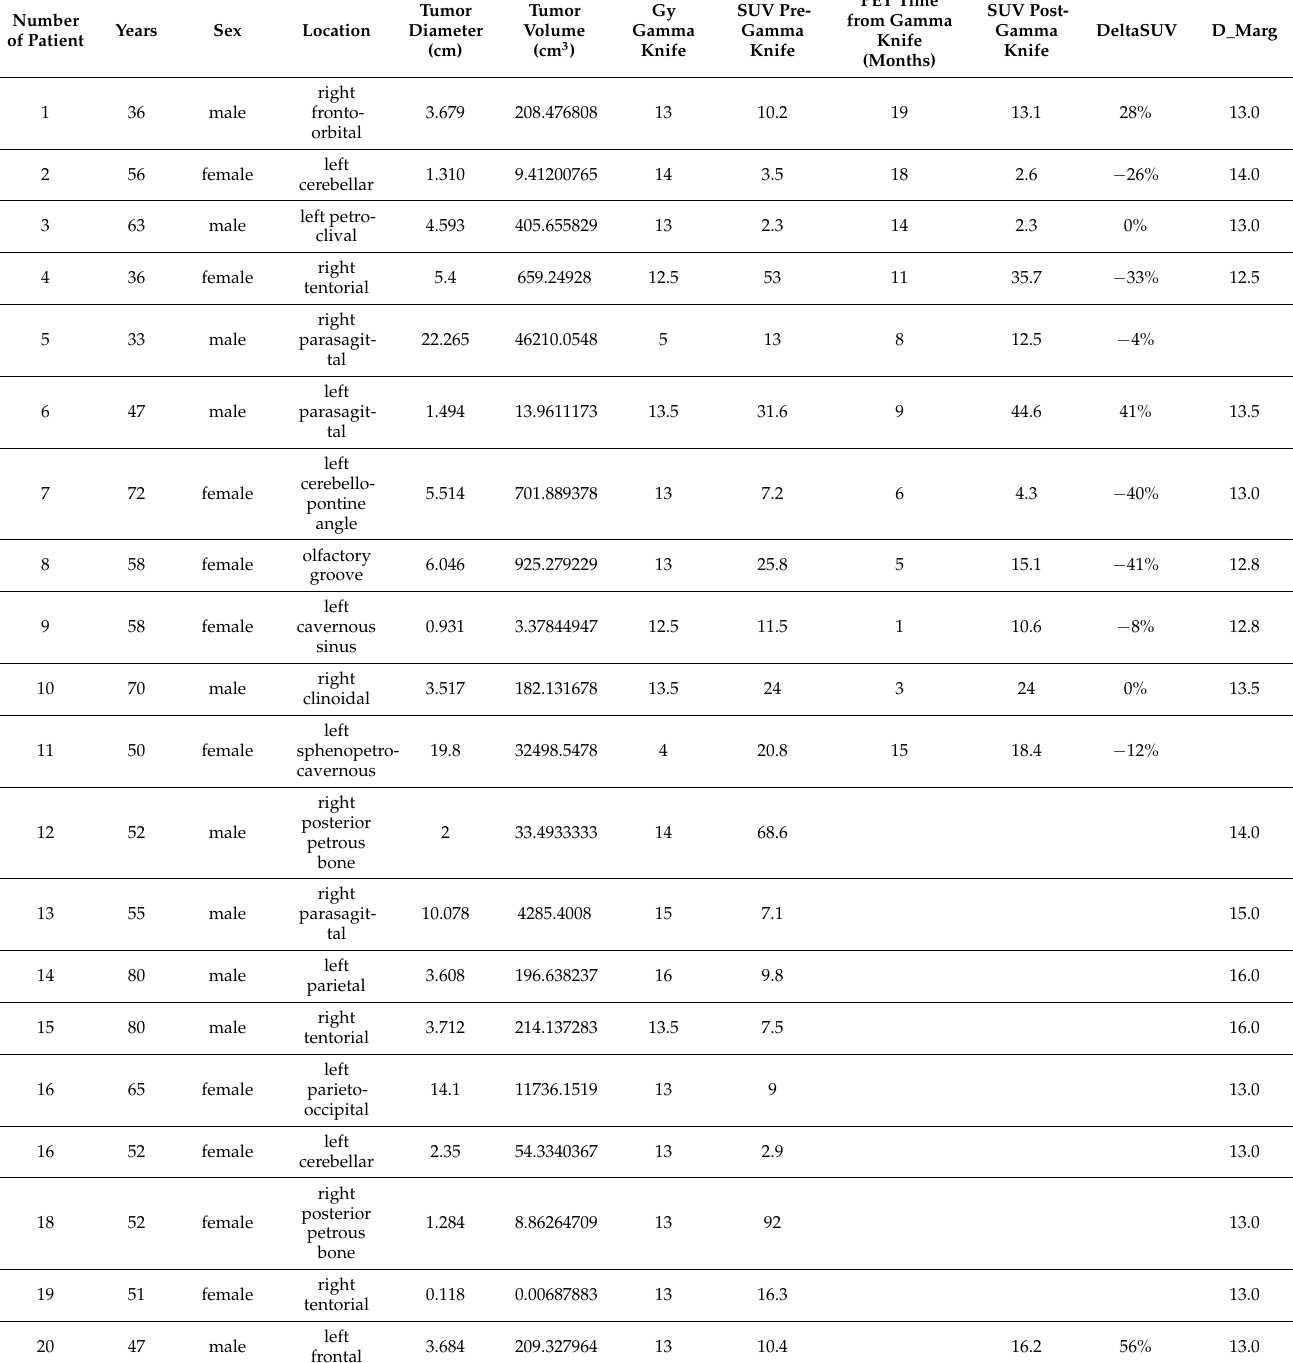
Table 1. Patient population characteristics and summary of the tumor size, SUV values, and Gamma Knife ICON dose administration.